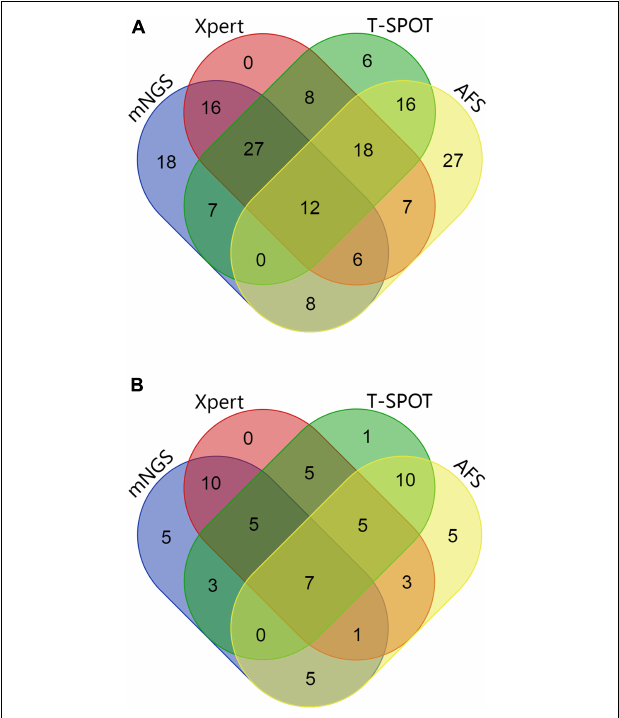
FIGURE 3 | (A) Wayne diagram showing the evaluation of the performances of mNGS, Xpert, AFS (BALF samples), and T-SPOT (sera samples) with respect to the detection of MTB and NTM. (B) Wayne diagram showing the evaluation of the performances of mNGS, Xpert, AFS (BALF samples), and T-SPOT (sera samples) in immunocompromised patients for the detection of MTB and